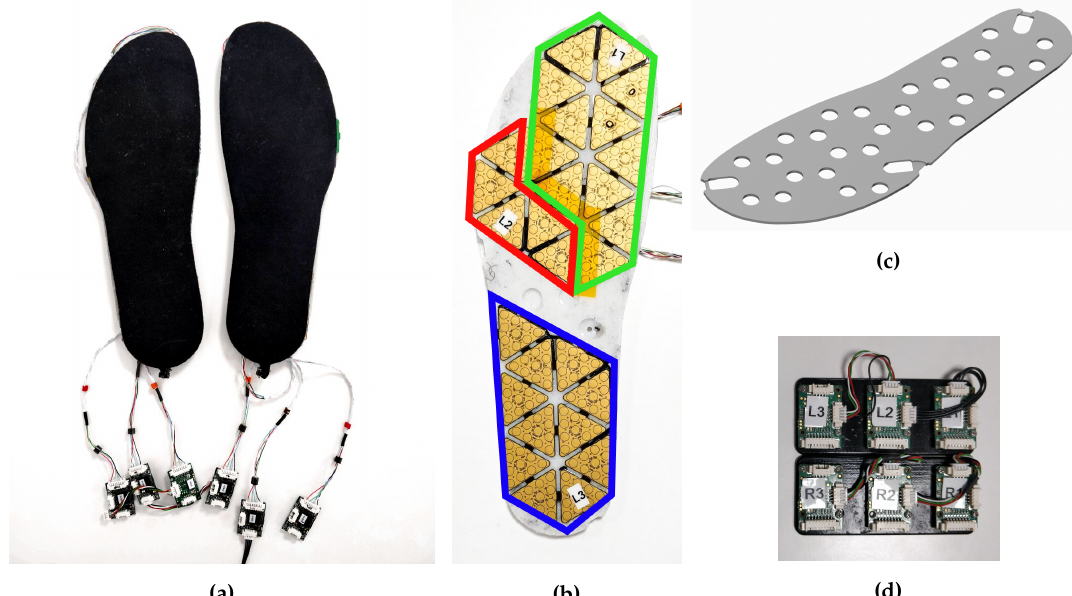
Figure 4. ( a ) Insoles prototype. ( b ) Inner part of the insole containing the gaps that accommodate the digital converter integrated circuits. ( c ) Computer-Aided Drafting (CAD) design of the support for the electronics. ( d ) Micro-controller tactile boards (MTBs) consistency: one for each patch of the